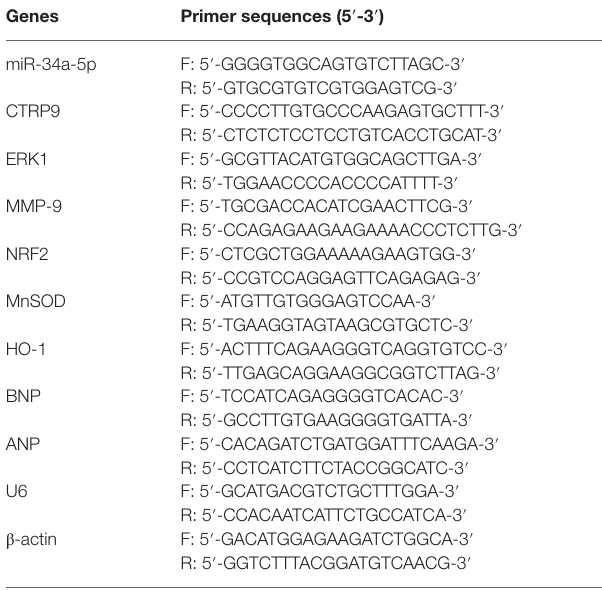
TABLE 1 | Primer sequences for